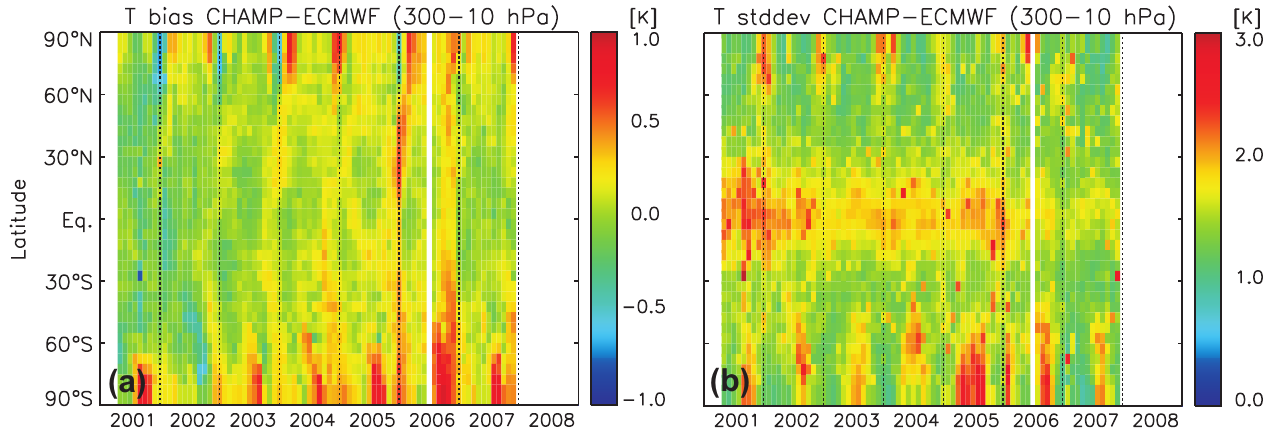
Fig. 3. Zonal monthly mean temperature bias (a) and stddev (b) between CHAMP and ECMWF averaged over the pressure (altitude) range 300–10hPa. The meridional resolution is 5 ◦ between 77.5 ◦ N–77.5 ◦ S and 10 ◦ for 85 ◦ N and 85 ◦ S (34 latitude bands).